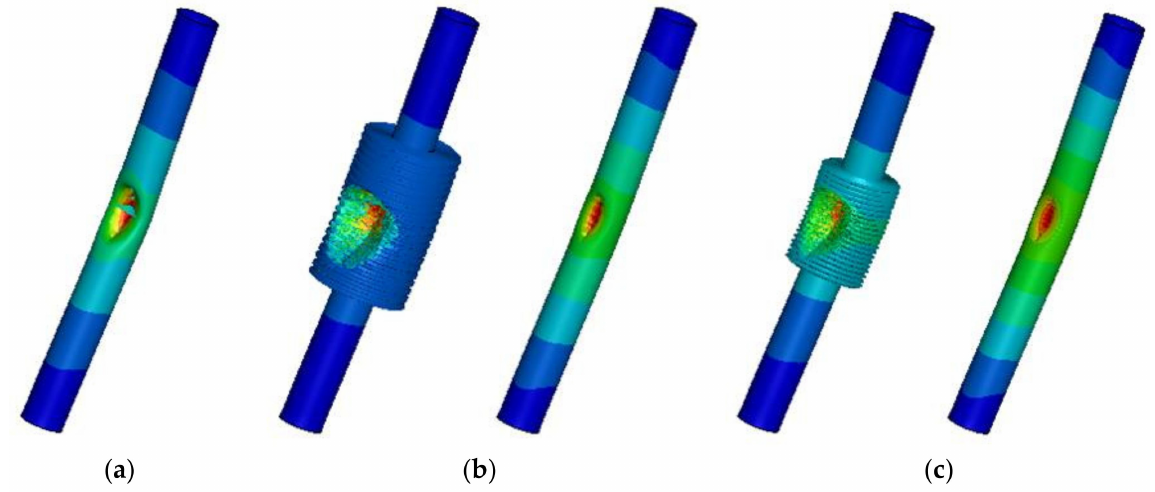
Figure 12. Deformation of the pipe under ship collision. ( a ) unreinforced pipe; ( b ) hexagonal honeycomb reinforced pipe; and ( c ) arrow honeycomb reinforced pipe.